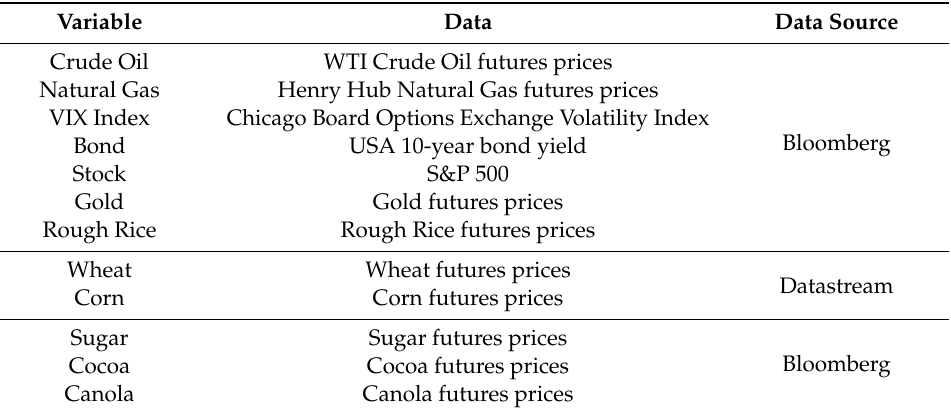
Table 1. Exploratory variables in the